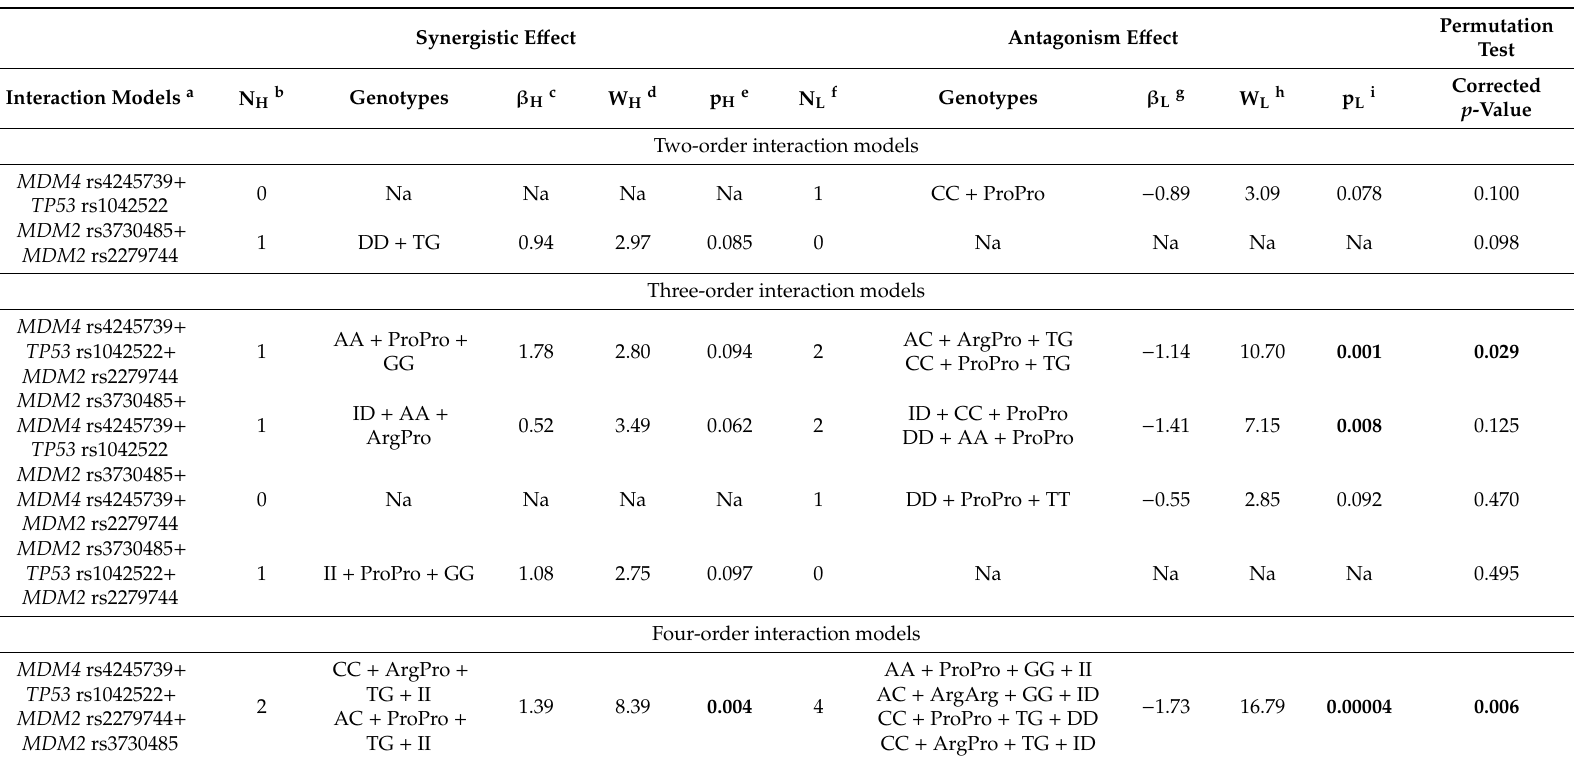
Table 4. Results of the model-based multifactor dimensionality reduction method in the second-step